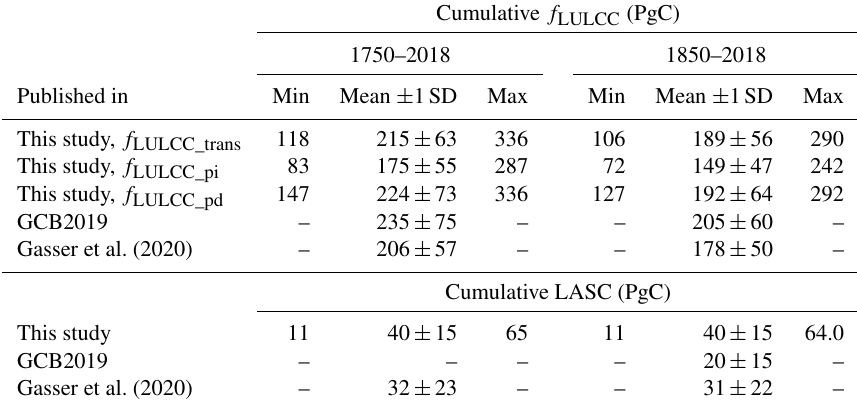
Table A3. Overview of global cumulative f LULCC and LASC estimates from this study: the ensemble of 15 DGVMs and of two bookkeeping models (BLUE, Hansis et al., 2015 and Houghton and Nassikas, 2017) from the annual global carbon budget (GCB2019, Friedlingstein et al., 2019) plus another recent bookkeeping estimate (Gasser et al., 2020). Emissions from peat fire and drainage were removed from the bookkeeping estimates to be better comparable to the DGVMs. Note that mean cumulative GCB2019 estimates are based on bookkeeping models, while their uncertainty is derived from DGVMs. LASC estimates from GCB2019 and Gasser et al. (2020) are based on two different versions of OSCAR, which is constrained by DGVM estimates. Minimum, maximum, and mean with standard deviation refer to the model